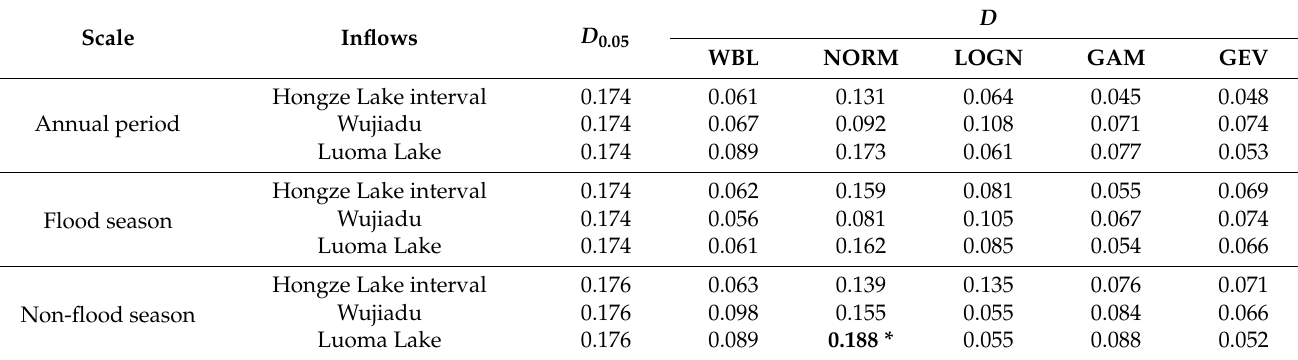
Table 1. Fitting test for marginal distributions of each